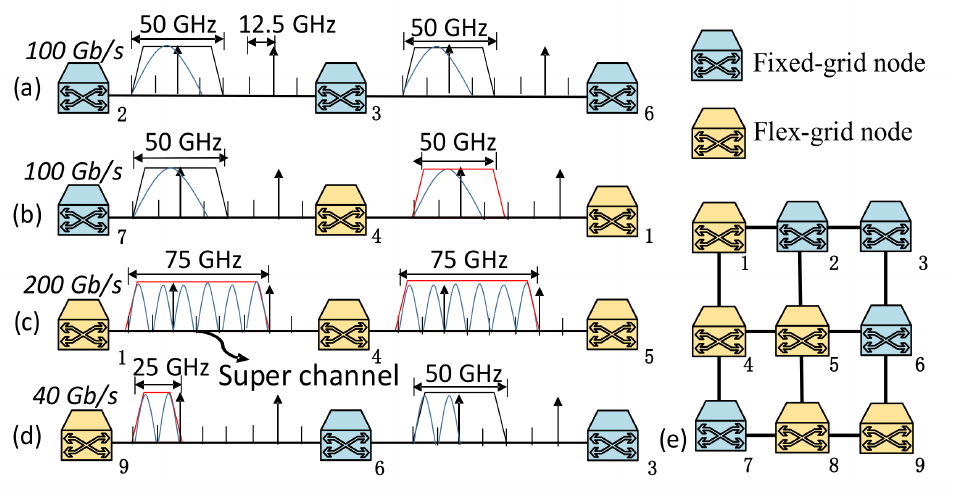
Figure 1. Different mixed-grid scenarios. ( a ) The 1st case ( b ) The 2nd case ( c ) The 3rd case ( d ) The 4th case ( e ) 9-node